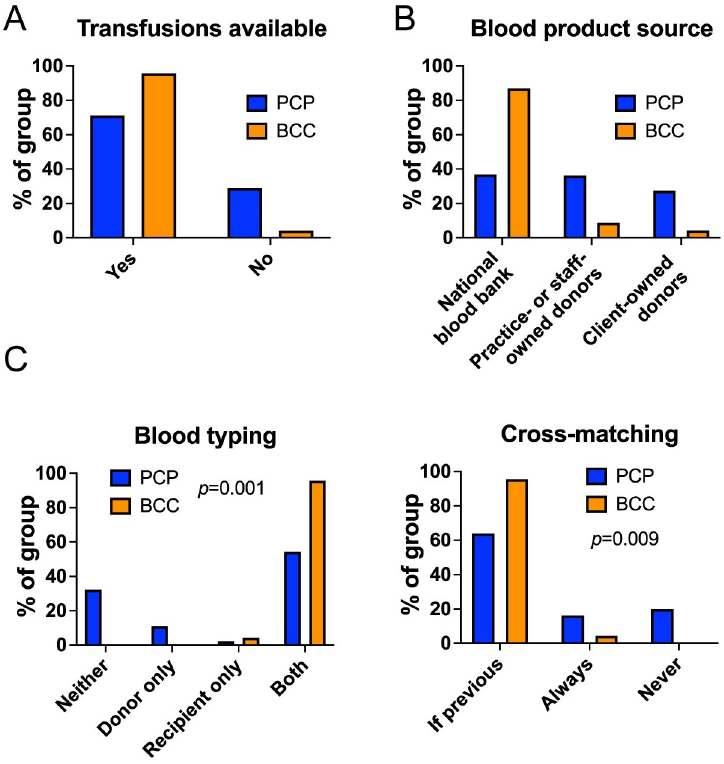
Fig 4. Blood transfusions are widely available in veterinary practice but extent of pre-transfusion testing differs. ( A ) Graph showing proportion of respondents in primary care practice (PCP, n = 191) or of board-certified clinicians (BCC, n = 24) reporting availability of blood transfusions in their practice. ( B ) Graph showing proportion of PCP and BCC respondents reporting indicated sources of blood products in their practice. ( C ) Graphs showing proportion of PCP and BCC reporting use of blood typing (left) and cross-matching (right) in their practices. Chi-squared or Fisher’s exact tests.